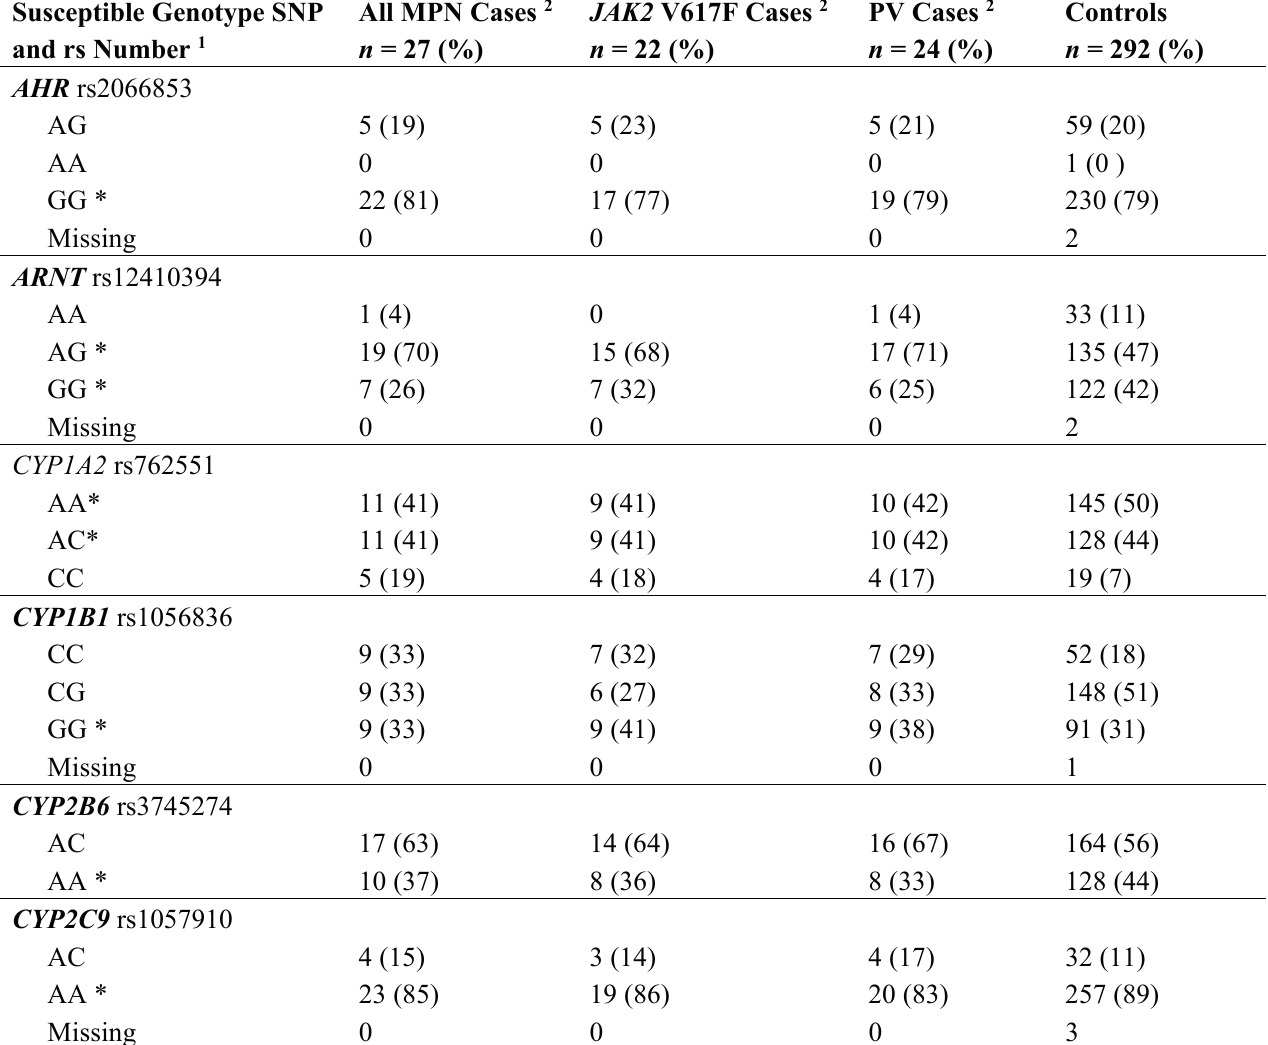
Table A1. The Distribution of Variants of Environmentally Sensitive Genes in the Study Sample; Reference Group Identified by an asterix